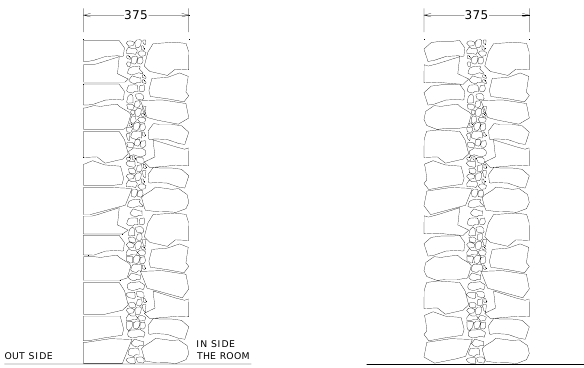
Figure 1 Cross-section of the typical stone masonry Fig. 1. Cross-section of the typical stone masonry load-bearing load bearing walls practiced in Himalayan. From walls practiced in the Himalayan region. From left to right: half- left to right: half-dressed coursed masonry wall dressed coursed masonry wall employed for public buildings (in- vestigated in the present study) and undressed random masonry wall employed for public buildings (investigated in the employed for rural residential present study) and undressed random masonry wall employed for rural residential buildings.